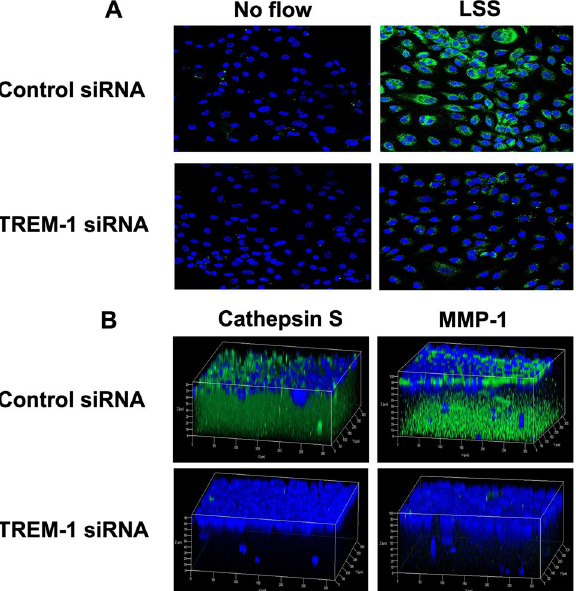
Figure 5. Suppression of TREM-1 protein expression by siRNA and its effect on the expression of matrix- degrading enzymes. ( A ) Suppression of TREM-1 expression by siRNA in monolayer culture of HCAECs. HCAECs were transfected with control-siRNA or TREM-1-siRNA as described in the “Methods”. Cells were then plated on coverslips and exposed to low ESS or no flow for 1 h followed by additional culture for 5 h. Cells were then fixed and immunofluorescence staining for TREM-1 was performed as described in the “Methods”. ( B ) Suppression of cathepsin S and MMP-1 protein expression in 3D co-cultures transfected with TREM-1 siRNA. HCAECs, HCASMCs and THP-1 cells were transfected with control-siRNA or TREM-1-siRNA for 6 h prior to preparing the 3D co-culture on coverslips. The cells were then exposed to low ESS for 1 h followed by additional culture for 5 h. Immunofluorescence staining for cathepsin S and MMP-1 were performed as described in the “Methods”. TREM-1: triggering receptor expressed on myeloid cells-1, siRNA: small interfering RNA, ESS: endothelial shear stress, MMP-1: matrix metalloproteinase-1, HCAECs: human coronary artery endothelial cells, HCASMCs: human coronary artery smooth muscle